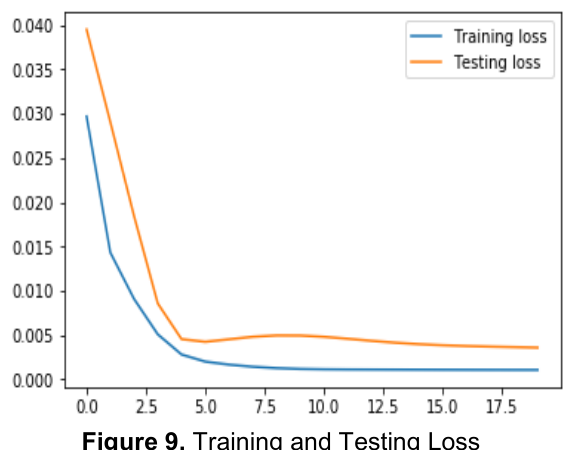
Figure 11. SVM Wind